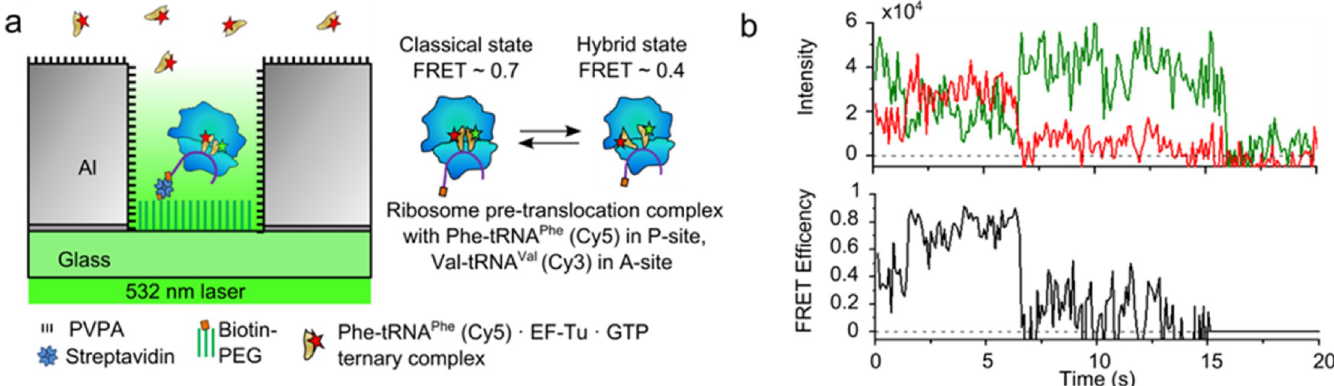
Fig 6. Application of devices to tRNA-tRNA FRET. (a) Schematic cartoon of ribosomes immobilized in an Al ZMW well via biotinylated mRNA, with FRET between Phe-tRNA Phe (Cy5) in the ribosomal P-site and Val-tRNA Val (Cy3) in the A-site. The ribosomes were illuminated by 532 nm laser light, in the presence of 500 nM Phe- tRNA Phe (Cy5) � GTP � elongation factor-Tu (ternary complex) in solution. (b) Example FRET trace from a ribosome transitioning from the low FRET hybrid state to the high FRET classical PRE-translocation state before photobleaching of Cy5 at 7 s followed by photobleaching of Cy3 at 15 s.